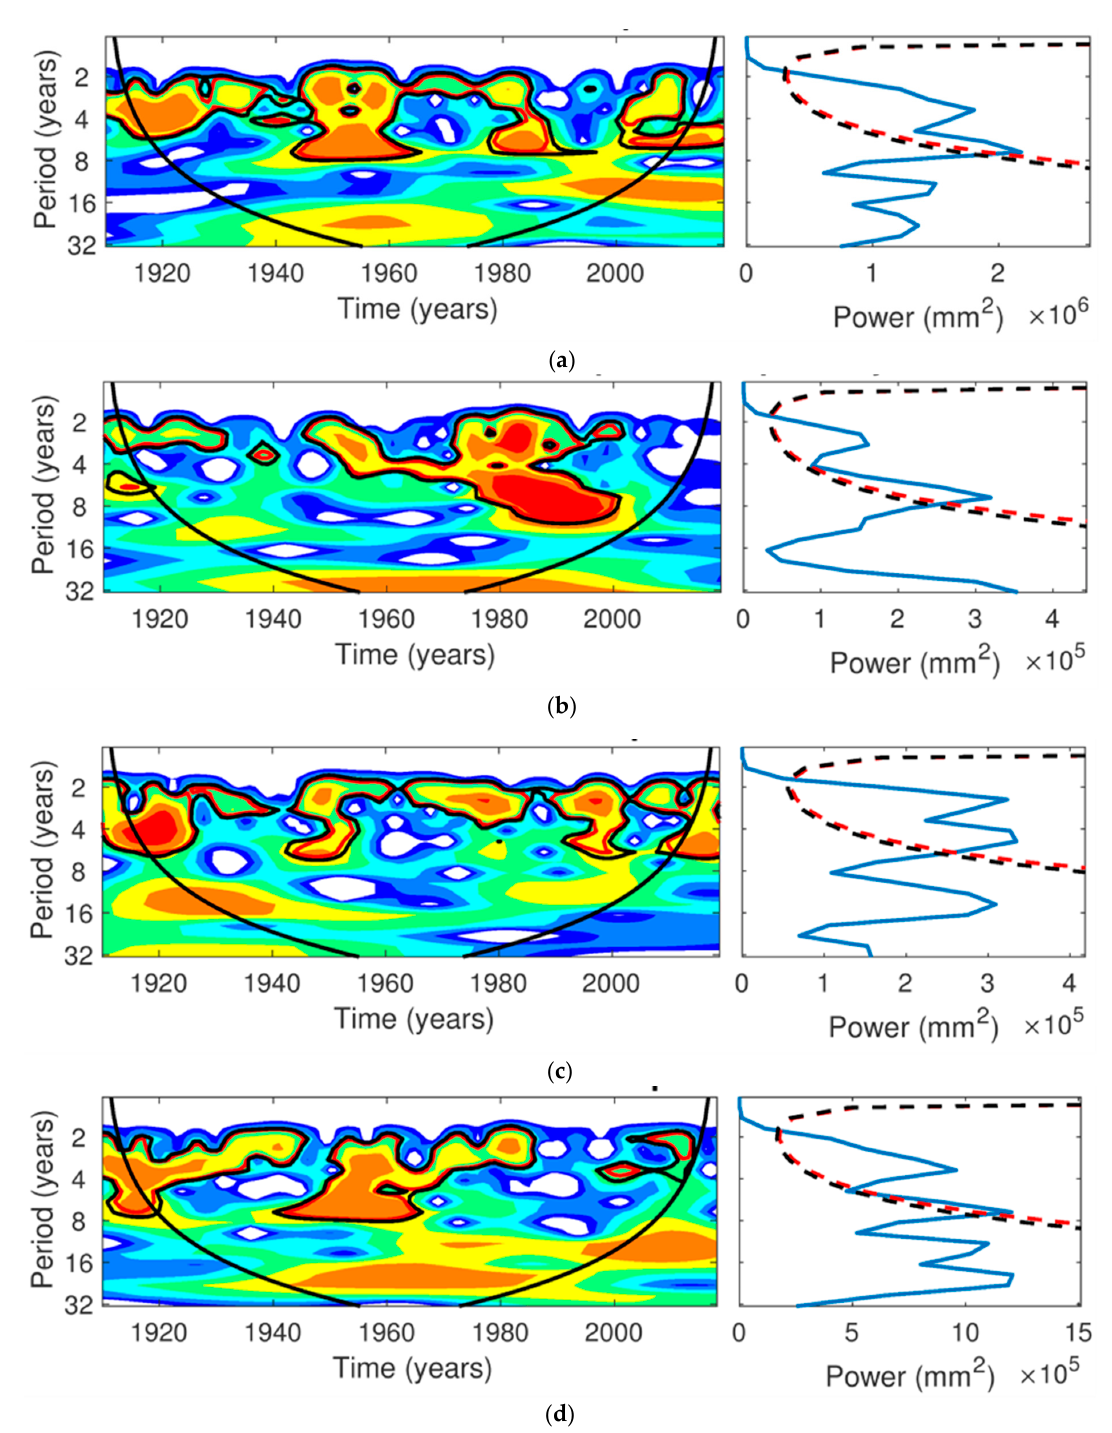
Figure 6. Wavelets for precipitation. Wavelets representing NMDB precipitation for the periods, ( a ) annual, ( b ) April–May, ( c ) JJAS, and ( d ) October–March. The local wavelet power spectra are displayed in the left sub-figure, while the global wavelet power spectra that represent globally dominant periodicities in the time series are displayed in the right sub-figure. The dashed black and red lines are the 90th and 95th confidence percentiles, respectively. The black cone shape on the local wavelet power spectra displays the cone of confidence.